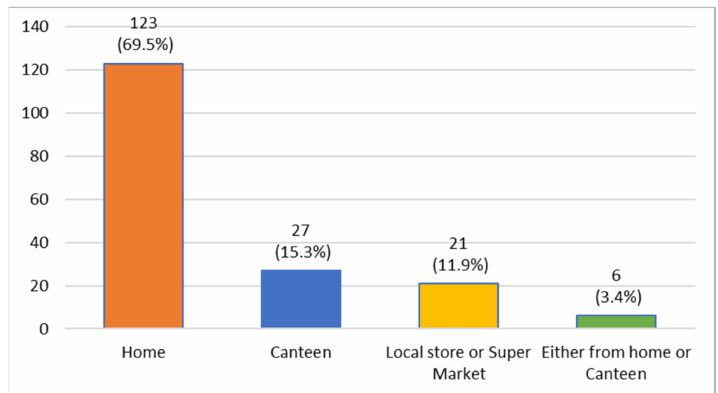
Figure 7. Distribution of the answers given by children regarding morning snacks.